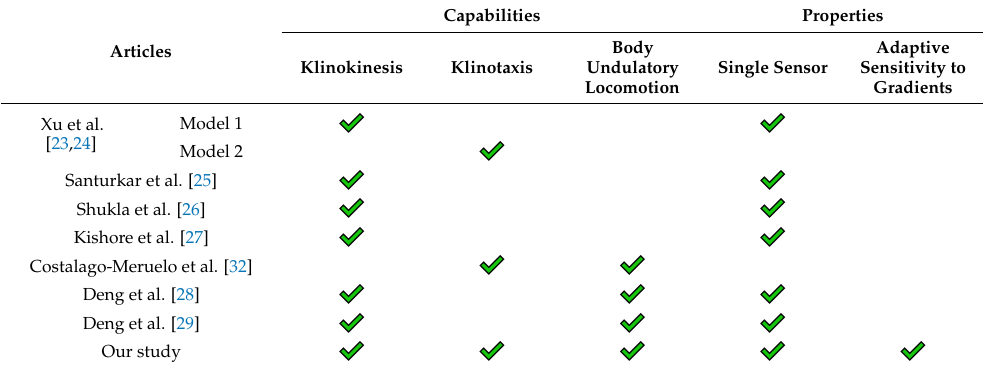
Table 2. Comparison of capabilities and properties of models in the literature and in our study ( (cid:6448)(cid:6449) represents the presence of this capability or property in the model).